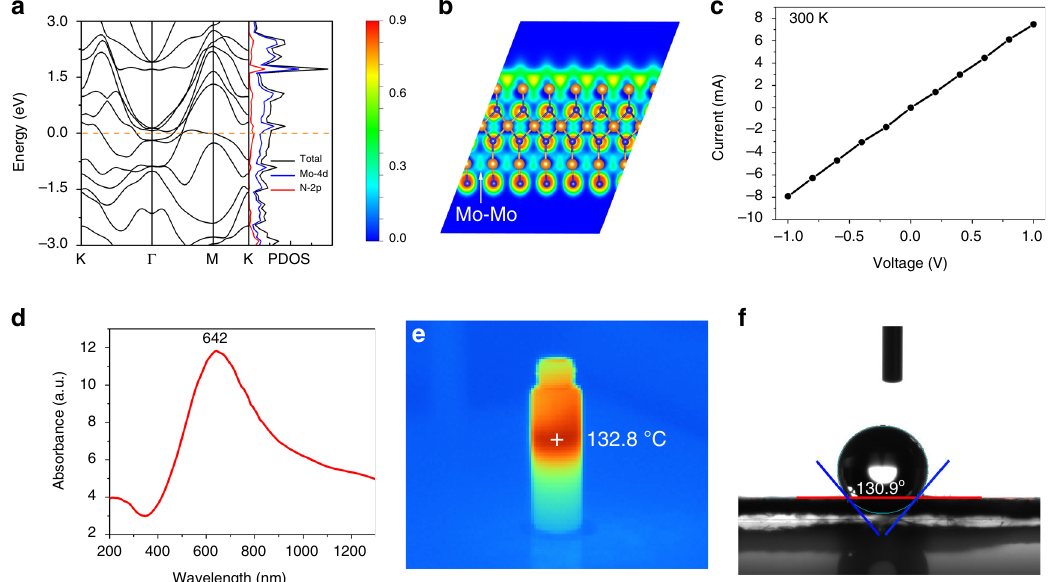
Fig. 6 Characterization of the physical properties of δ − MoN nanosheets. a , b DOS and EIF of δ − MoN. c I – V curves of the δ − MoN nanosheets at 300 K. d UV-Vis absorption of the δ − MoN nanosheets. e Photothermal effect of the δ − MoN nanosheets. f Contact angle measured at the interface of water drop and with high conductivity (Supplementary Table 1). The δ − MoN irregular particles) only exhibits weak absorption in the visible nanosheets exhibit a strong LSPR absorption from visible to near region (Supplementary Fig. 18). The reason for this different infrared regions, and the center of the absorption is at 642 nm optical phenomenon may be because the nanosheet has a larger (Fig. 6d). In contrast, commercial δ − MoN powder (micron scale light-absorbing surface, a thinner thickness, and a large number